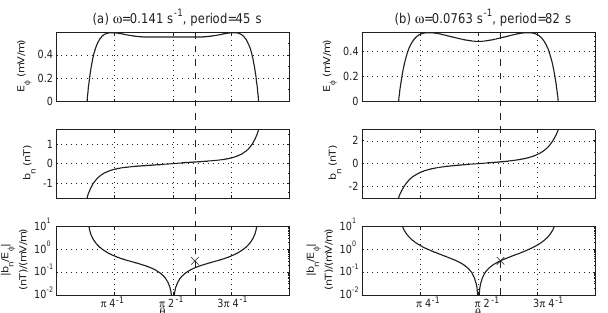
Figure 11. The solutions of E φ (in mV/m), b n (in nT) and the ratio inbetween (from top to bottom panels) for the compressed dipole on the (a) noon side and (b) midnight side, to be compared with the spacecraft observations of Dai et al. (2013). The vertical dashed line denotes the spacecraft location and the cross marks the measured ratio ( ∼ 0 . 3nT/(mV/m)) during the time period of